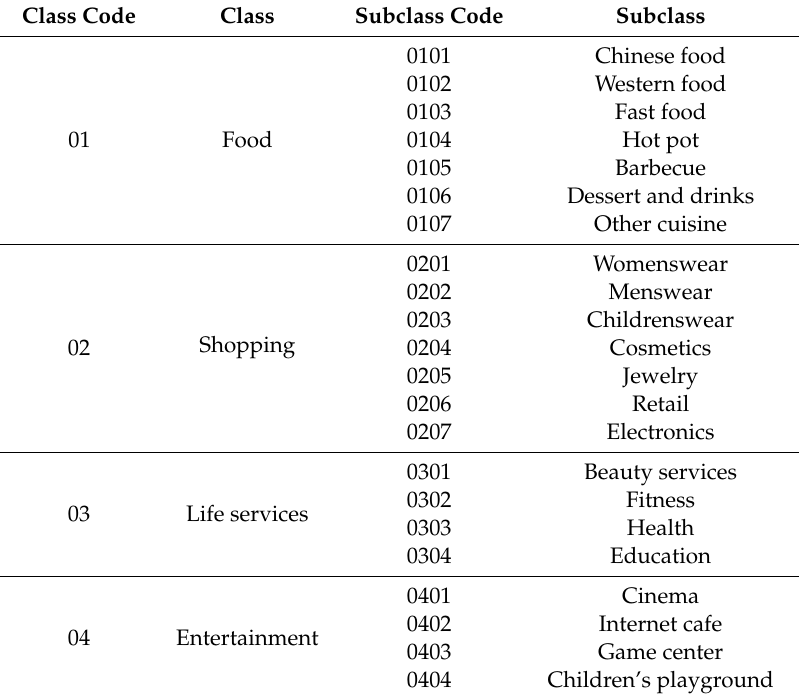
Table 3. Hierarchical classification of indoor